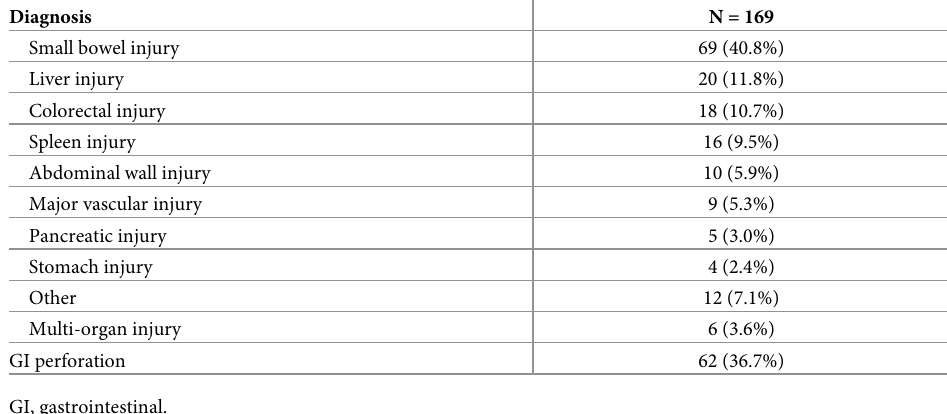
Table 2. Patient